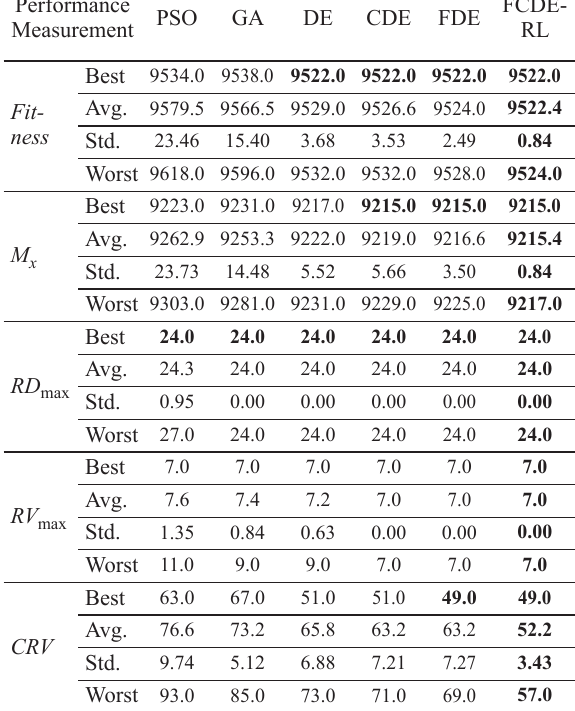
Table 7. Result for different objective functions optimized by FCDE-RL Before No Leveling